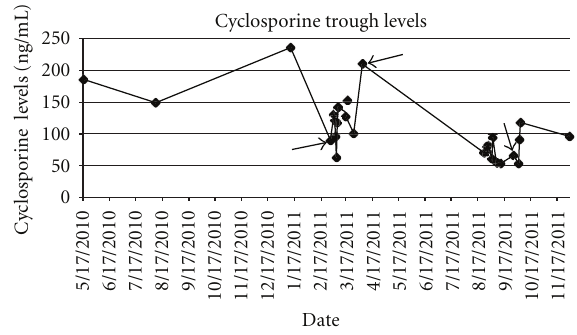
Figure 1: Cyclosporine trough levels.